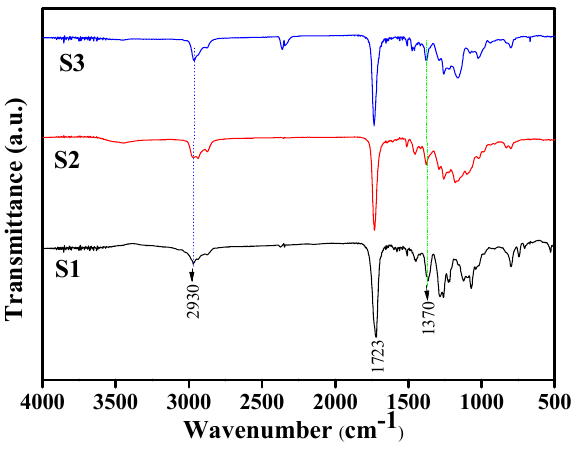
Figure 1. FT-IR spectra for S1, S2 and S3.